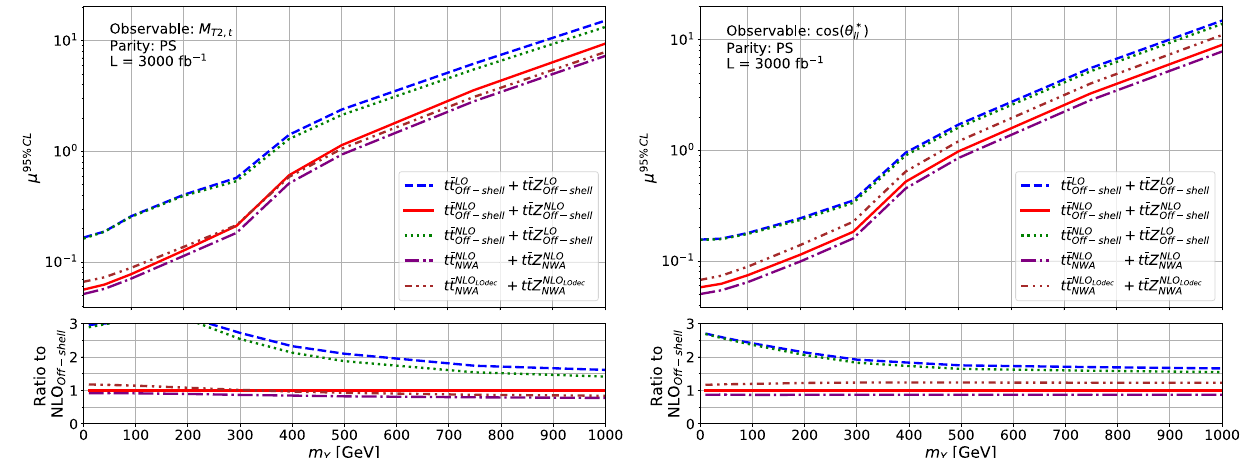
Fig. 15 Comparison of signal strength exclusion limits computed with differentbackgroundpredictionsforthepseudoscalarmediatorscenario with a luminosity of L = 3000 fb − 1 and using M T 2 , t (left) and cos (θ ∗